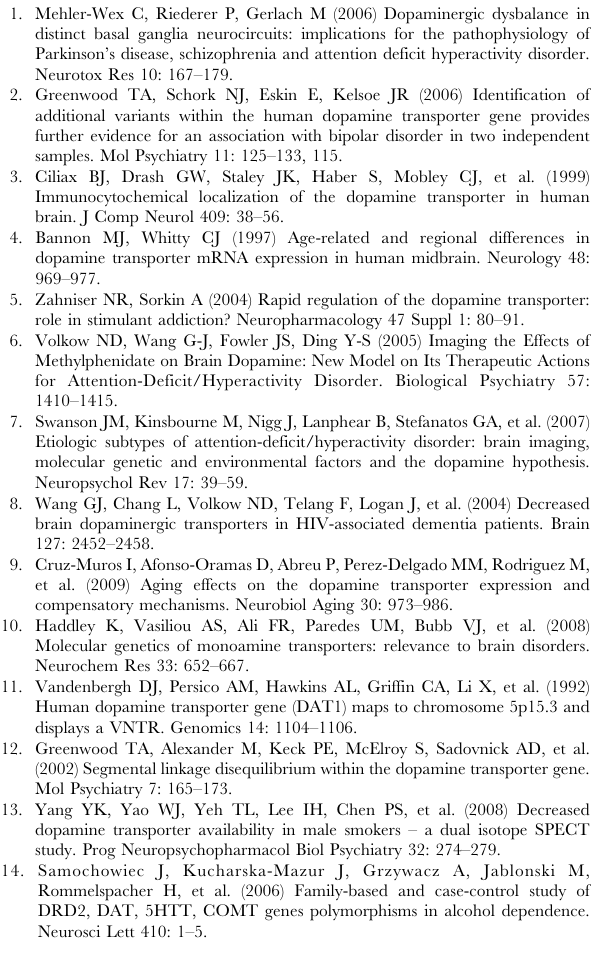
association is considered (upper panel, red arrow) or discounted (lower panel, red arrow). Table S1 Known SNPs in the SLC6A3 locus. Table S2 Tandem repeats in the SLC6A3 locus with a period longer that 30 nt. Table S3 Tandem repeats in the SLC6A4